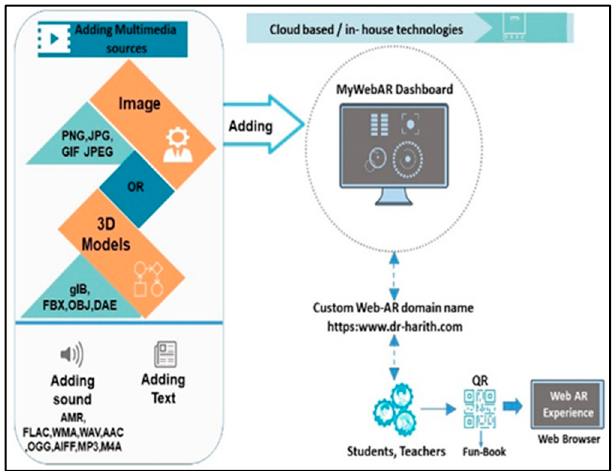
Figure 2. Web AR Development Over View .